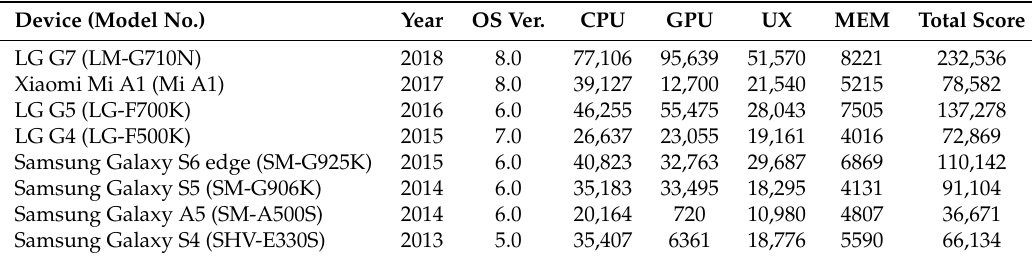
Table 2. AnTuTu benchmark scores on the Android smartphones.